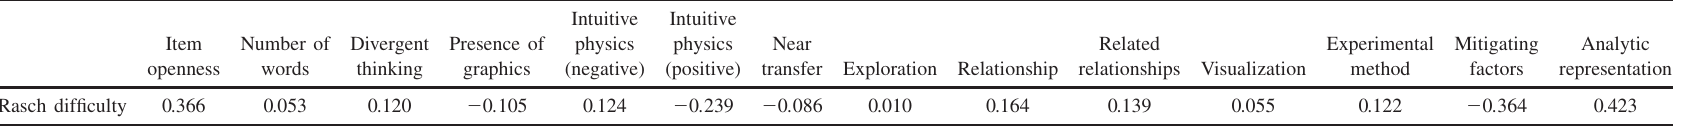
TABLE XIV. Partial correlation